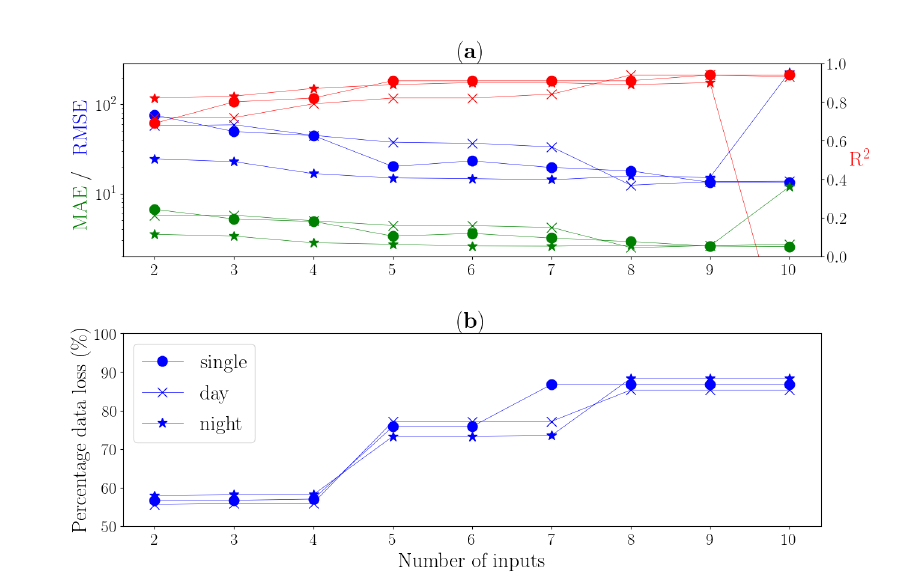
Figure 8. Proxy performance metrics and the percentage of data loss evaluated on testing data. In the subplot ( a ), the green, blue and red constitute the metrics of Mean Absolute Error (MAE), Root-Mean-Squared Error (RMSE) and coefficient of determination (R 2 ), respectively. The subplot ( b ) presents the percentage of data loss due to the involvement of more input numbers. For both subplots as shown the legend in subplot ( b ), the symbols (cid:13) , × and (cid:63) denotes the performances of single, day and night models,